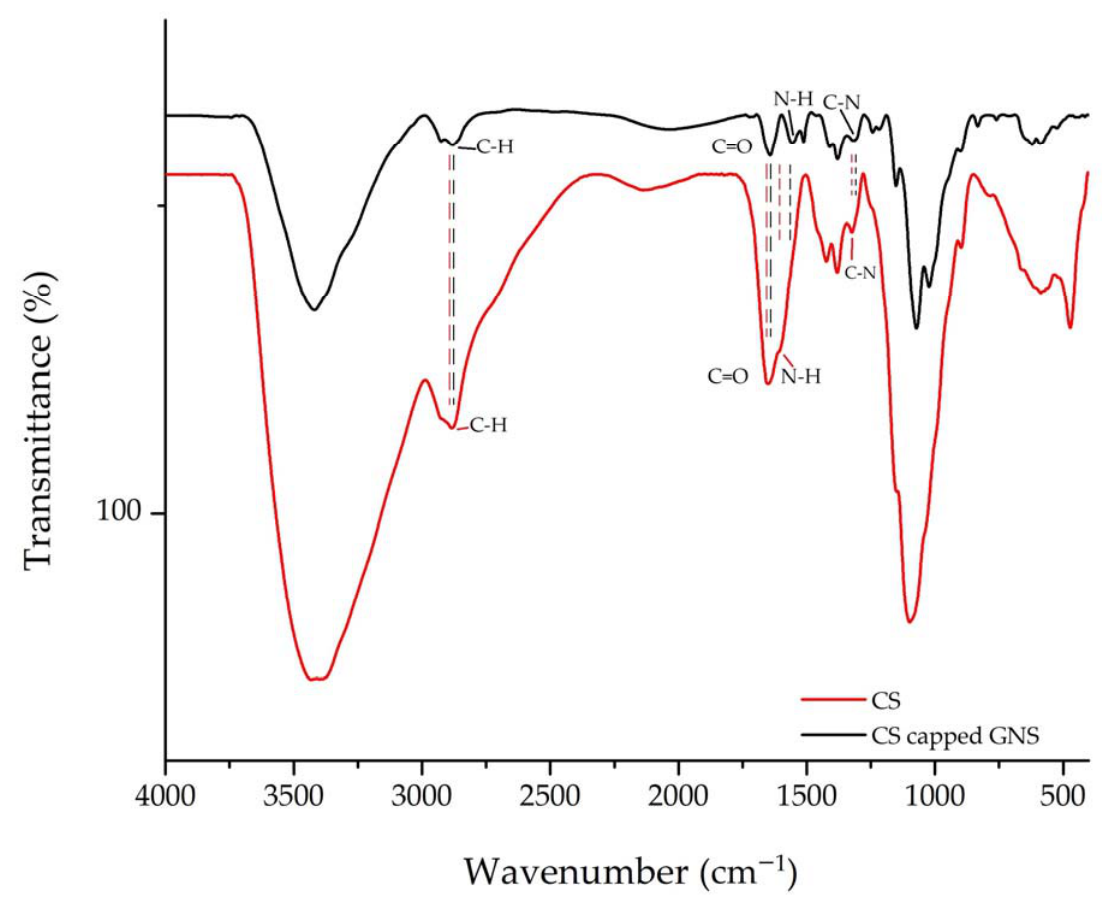
Figure 11. FT–IR spectrum of CS and CS-coated